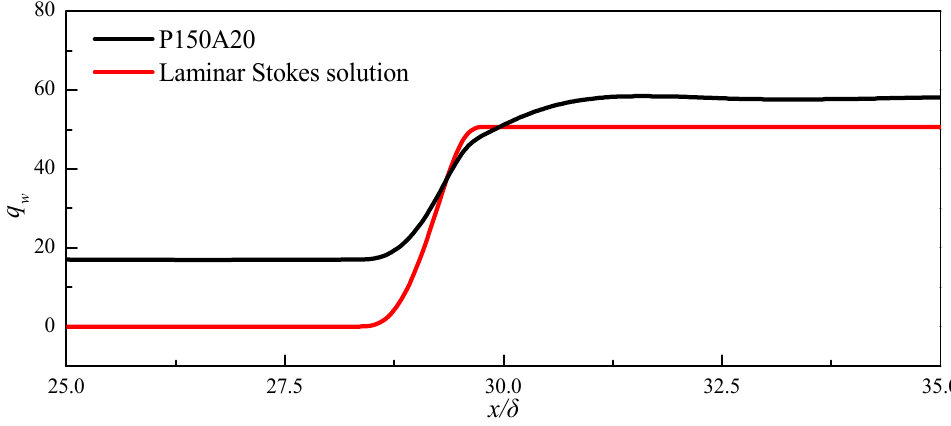
Figure 9. Averaged WHF of laminar Stokes solution and Case P150A20.